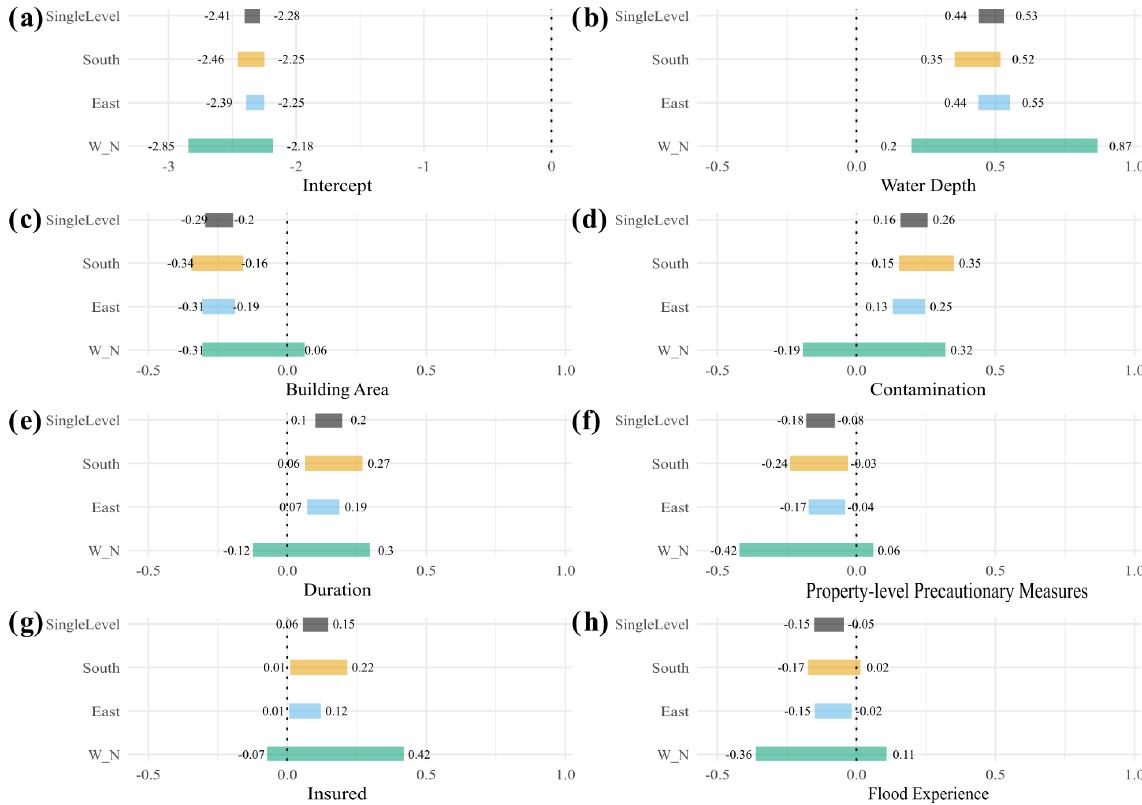
Figure 4. The 95% HDI of regression estimates of the regional model (across three regions; coloured segments) and the single-level model (black segments). The intercept is the sum of the population-level effect (common across levels) and group-level effects (for each